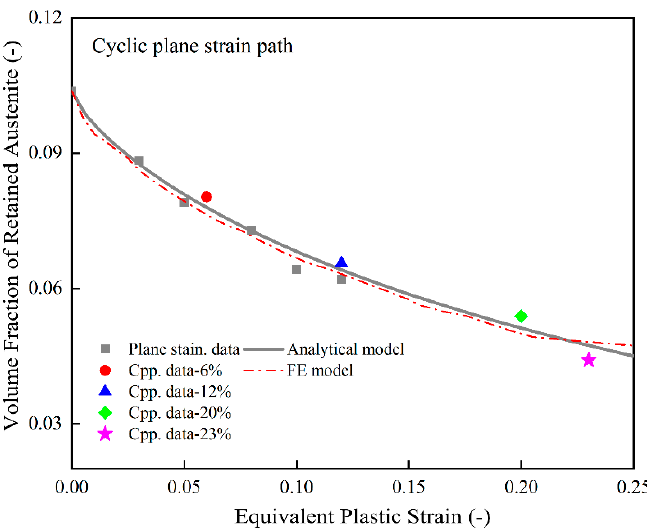
Figure 13. Variation of retained austenite with EPS of cyclically loaded plane strain specimen: these include experimental results from tests of retained austenite volume fractions at EPS of 6%, 12%, 20%, and 25%, and predictions of VFRA from analytical model and FE model.